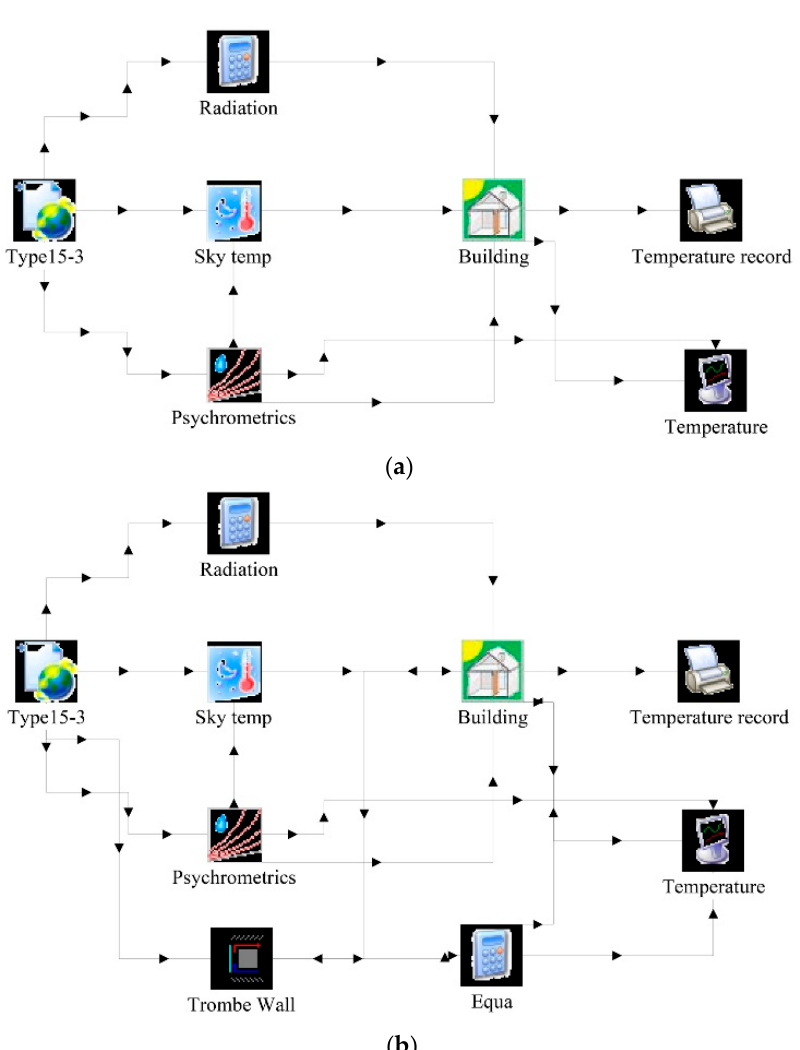
Figure 11. TRNSYS model for Case 1 and Case 2. ( a ) TRNSYS model for Case 1; ( b ) TRNSYS model for Case 2.